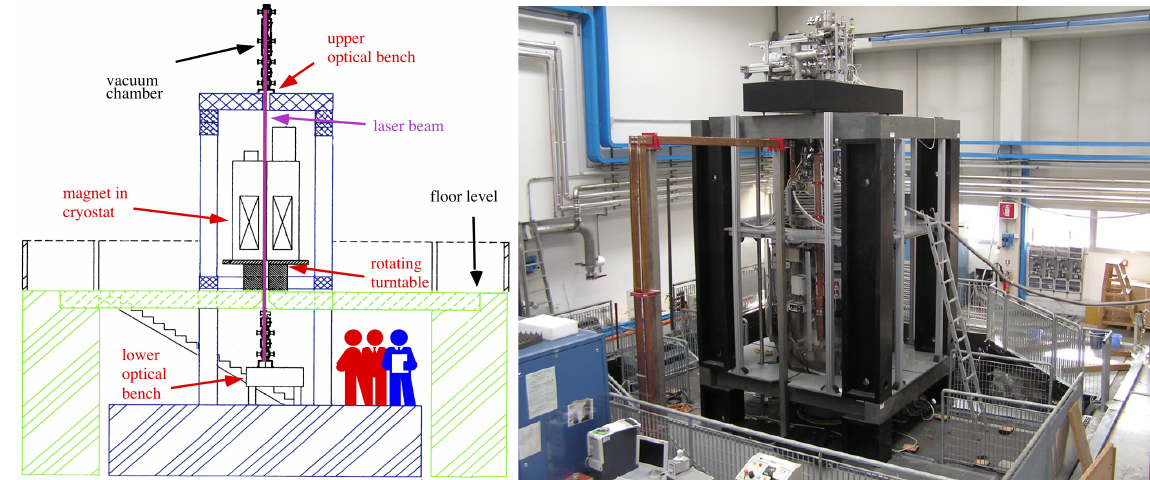
Figure 8. ( Left ) schematic drawing of the PVLAS-LNL setup. ( Right ) a photograph of the apparatus above the floor level. The lower optical bench is below the beam supporting the cryostat and sits about 3 m below ground level on a concrete